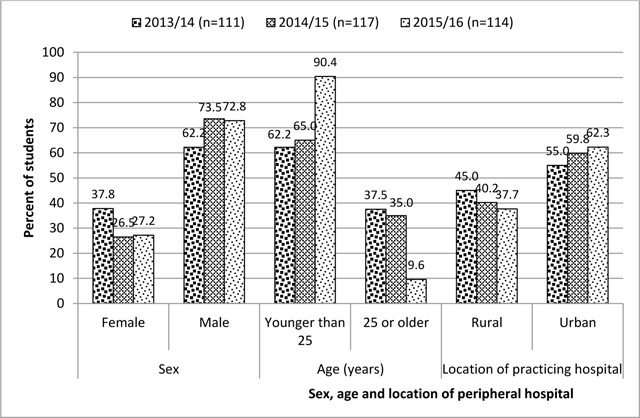
Distribution of students according to sex, age and location of placement peripheral hospital.